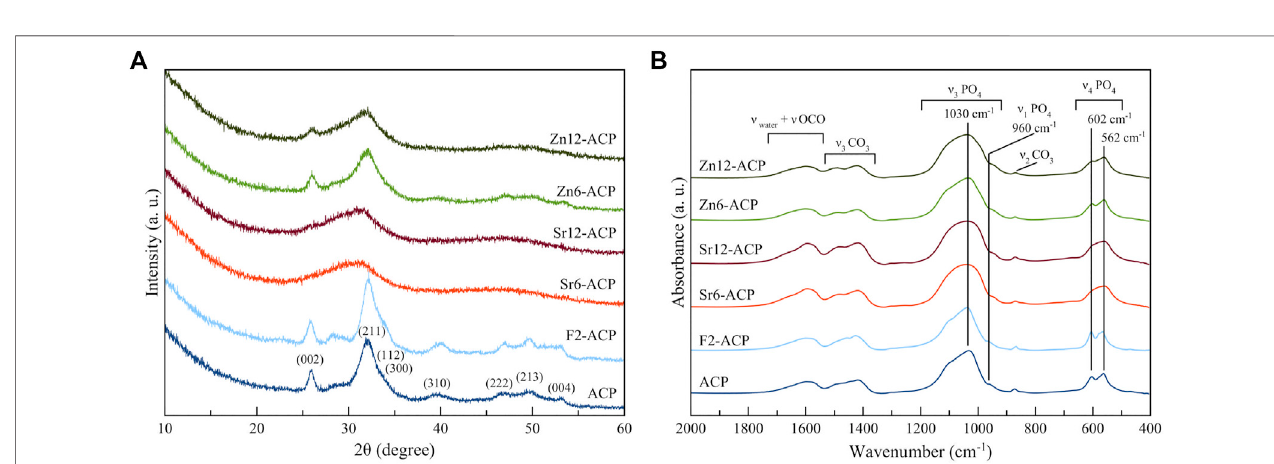
FIGURE 4 | (A) PXRD patterns and (B) FT-IR spectra of ACPs materials after incubation for 24 h at 37 ° C at pH